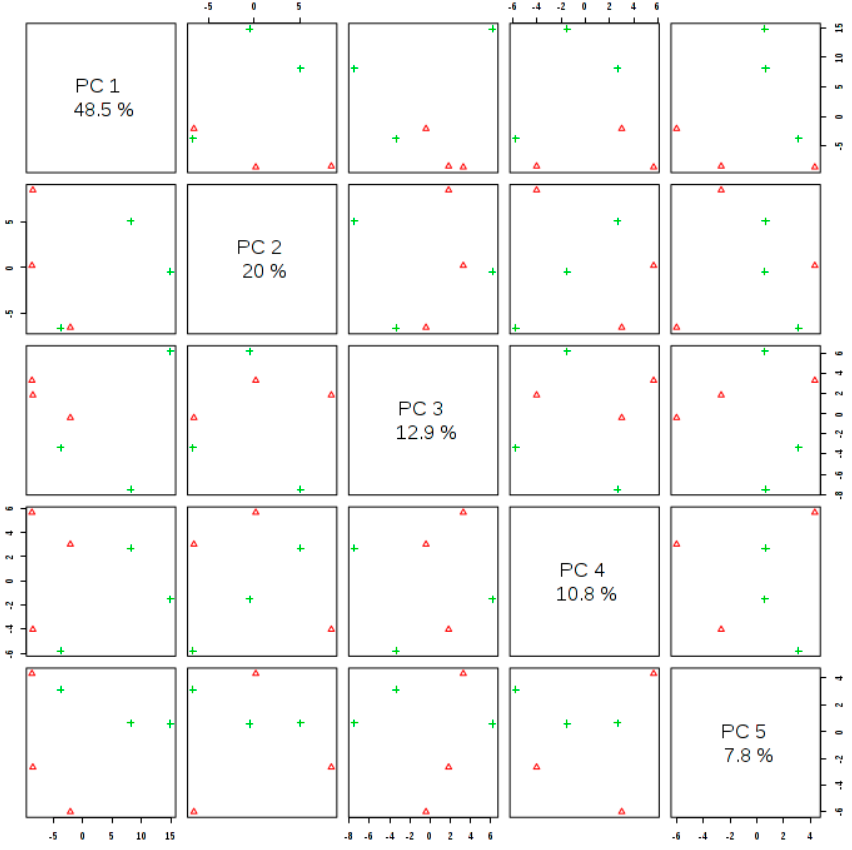
Figure 2. PCs generated in the PCA, which represent 100% of the variability of the data of extracts from Moringa oleifera leaves. Green triangles represent the samples treated with vermicompost and red cross represents data from the control treatment.